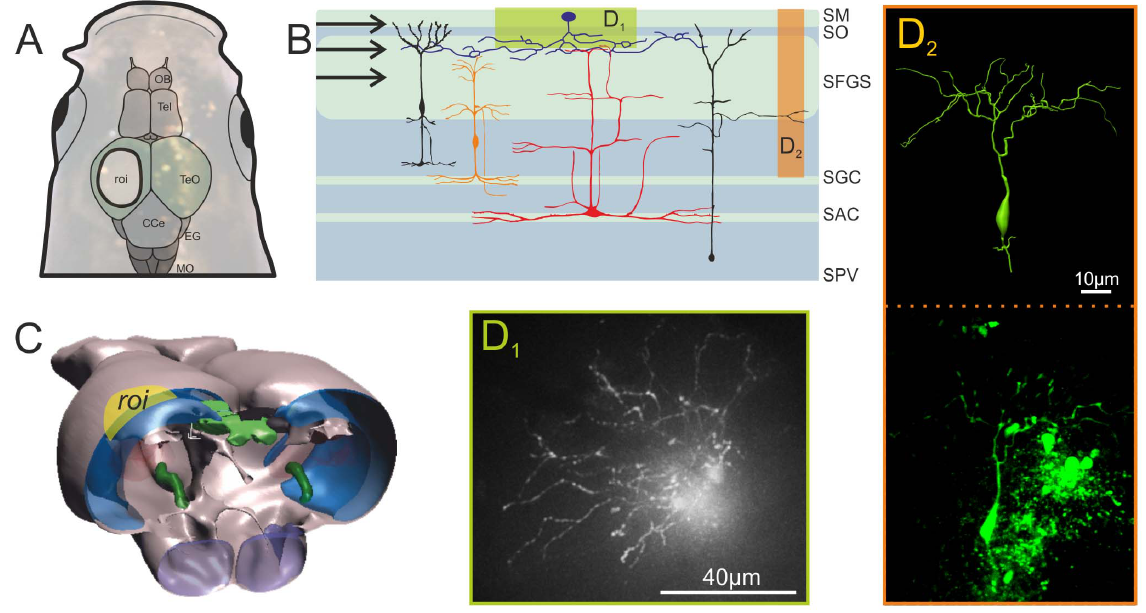
Figure 2. Morphology of neurons in the optic tectum of adult zebrafish. A. Image of the head of an adult zebrafish following exposure of the left tectum opticum. A schematic drawing of the brain is superimposed on the image of the head of a zebrafish. The region exposed for imaging is marked as the region of interest (ROI). B. Schematic transversal section through the tectum opticum (redrawn after [30]) showing the input layer and the overall cytoarchitecture of some prominent neurons. Areas highlighted in colour indicate where photomicrographs of labelled cells shown in D 1 –D 2 are located. C. Schematic three-dimensional view on the tectum. The ROI is highlighted in yellow, while the tectal areas are indicated in blue (BioVis3D). D 1 –D 2 . Photomicrographs of stained cells. D 1 shows an example of a top view using the in vivo imaging set-up (widefield fluorescence). D